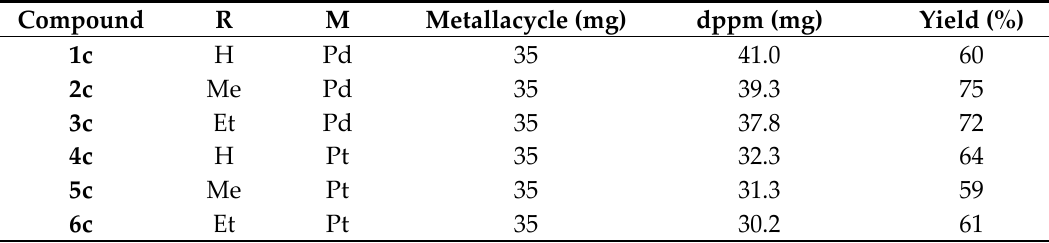
Table 3. Quantities of reagents added.